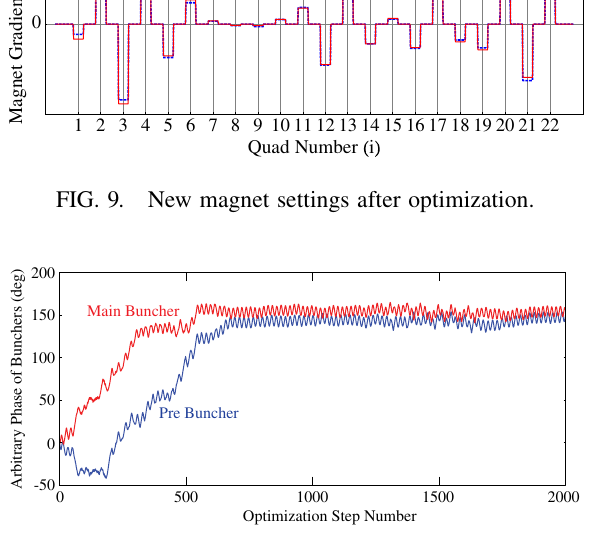
FIG. 10. Evolution of buncher cavity phase settings over 2000 iteration steps.